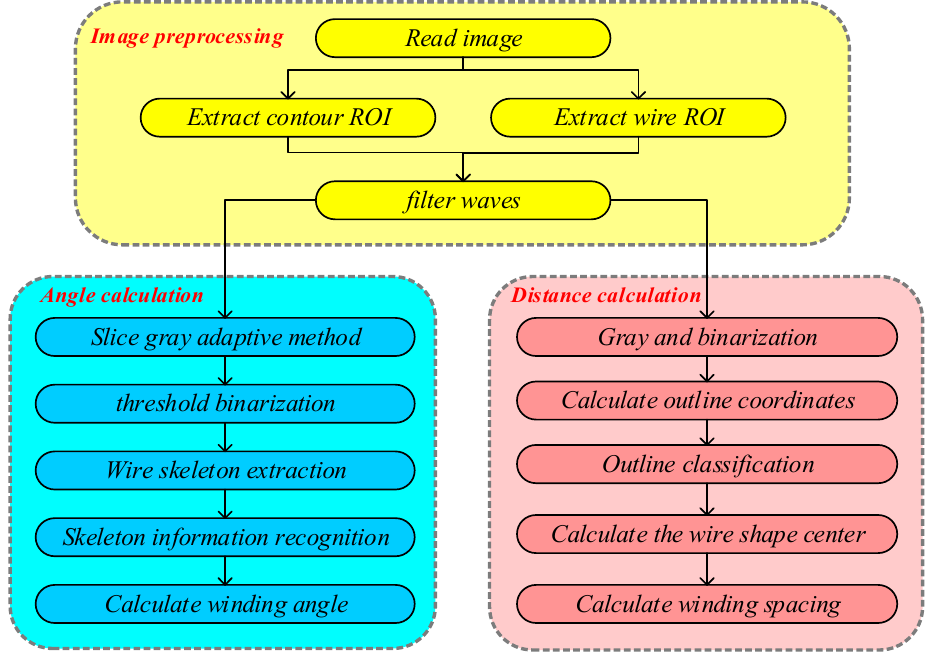
Figure 5. Design flow of the detect